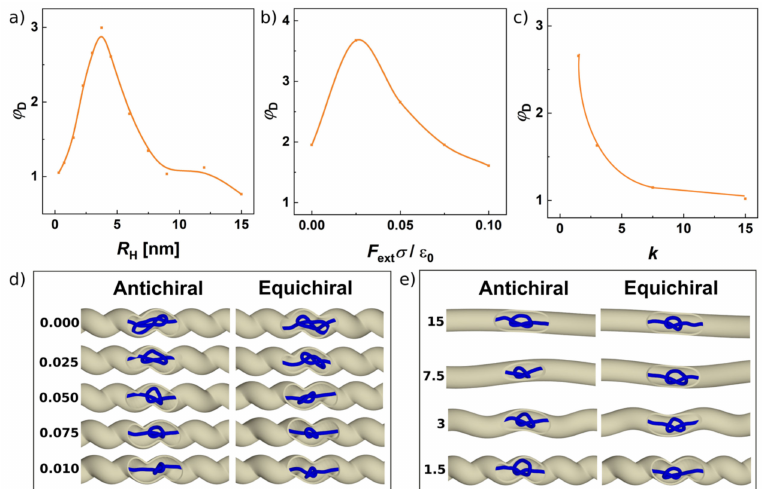
Figure 4. Stereoselectivity of the helical channel as a function of three parameters. ( a ) Effect of the radius of the helical channel on stereoselectivity of the channel in terms of ϕ D = D = / D ± . ( b ) Effect of the external pulling force F ext . ( c ) Effect of the distance between of the loops or steepness of the helical channel in terms of its pitch, k . ( d ) Snapshots from the simulations with varying external force, the values F ext σ / ε 0 are indicated as numbers, for antichiral and equichiral configurations and channels with R H = 1 σ . ( e ) The channels with various pitch parameters, k , indicated as numbers to the left in helical channels with R H = 1 σ . The lines are provided as visual